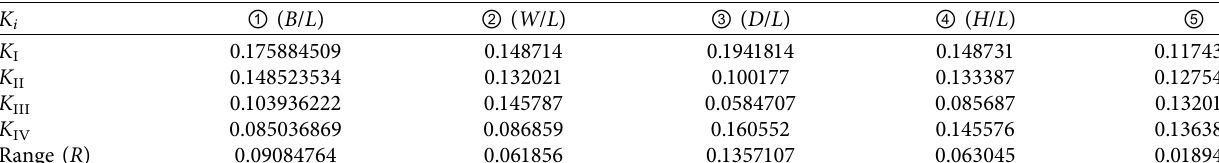
Table 7: K value of the orthogonal experiment.